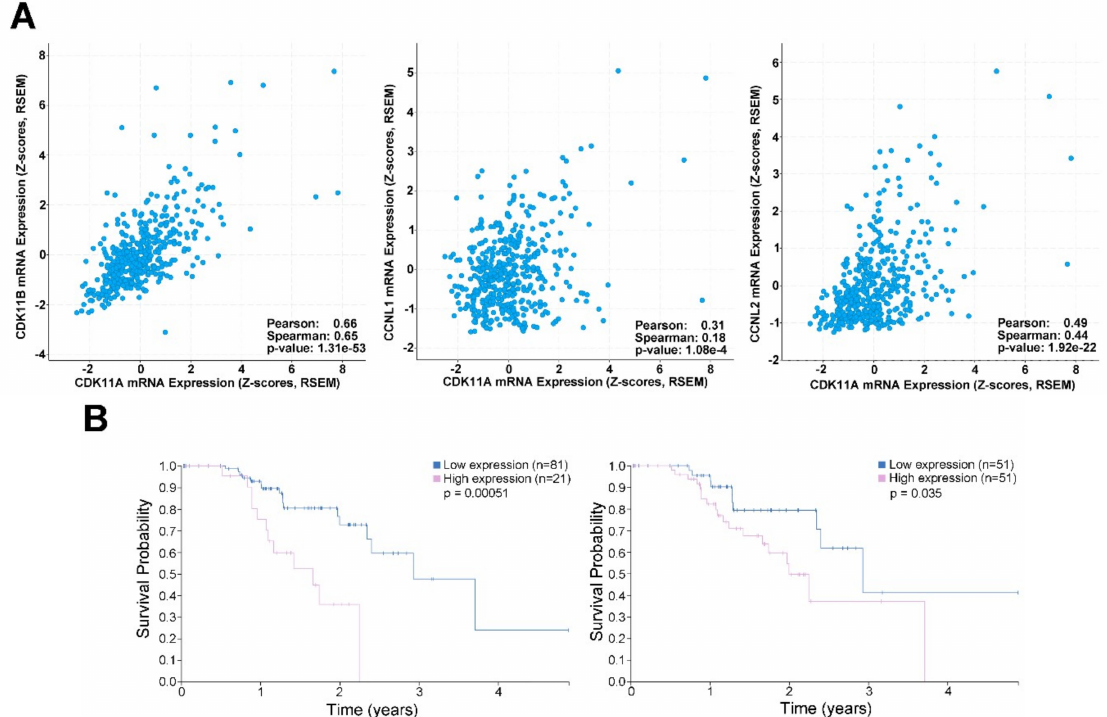
Figure 7. Expression of CDK11 and associated genes in melanoma patient samples and association with survival. ( A ) Analysis of co-expression of CDK11A, CDK11B, CCNL1 and CCNL2 mRNA levels in melanoma patient samples from The Cancer Genome Atlas (Pan-Cancer Atlas; n = 443 samples). Correlation analysis and p -values provided within each panel. Analysis performed using cBioPortal. RSEM, RNA-Seq by Expectation–Maximization. ( B ) Survival analysis in melanoma patients indicating that high CDK11A mRNA expression is unfavorable. Kaplan-Meier plots are shown for best expression cut-o ff (1.82; Left panel) and median expression cut-o ff (1.38; Right panel). n = 102 human cutaneous melanoma patient samples. p -values for log-rank tests are provided within each panel. Analysis performed by Human Protein Atlas using data from The Cancer Genome Atlas. Image credit: Human Protein